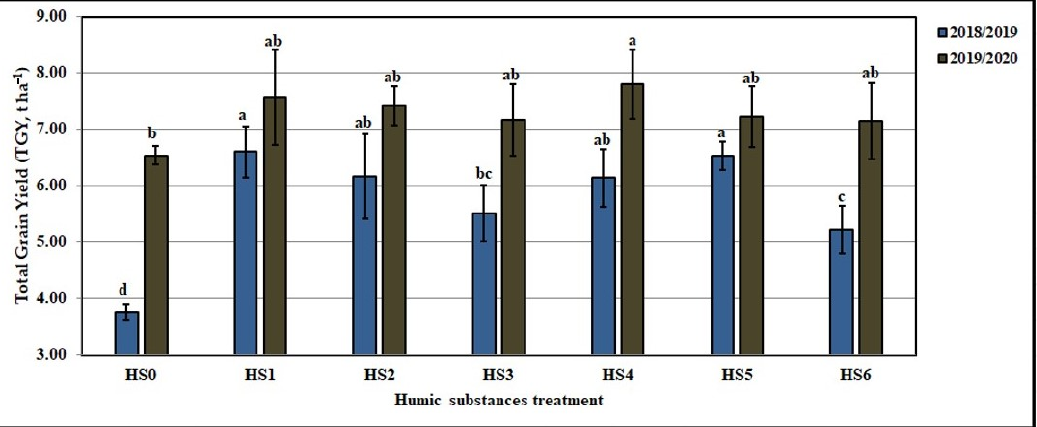
Figure 15. Influence of humic substances treatments on total grain yield (TGY, t ha ‒ 1 ) of some wheat varieties grown in clay loam soil in 2018/2019 and 2019/2020 seasons. Bars in the same years with a different letter indicate significant differences between treatments at p ≤ 0.01. HS 1, HS 2 , HS 3 represent HS applied as foliar spray at 1.0, 2.0, 4.0 g L − 1 , respectively, HS 4 , HS 5 , HS 6 represent HS applied as soil application at 5.04, 7.56, 10.08 kg ha − 1 .